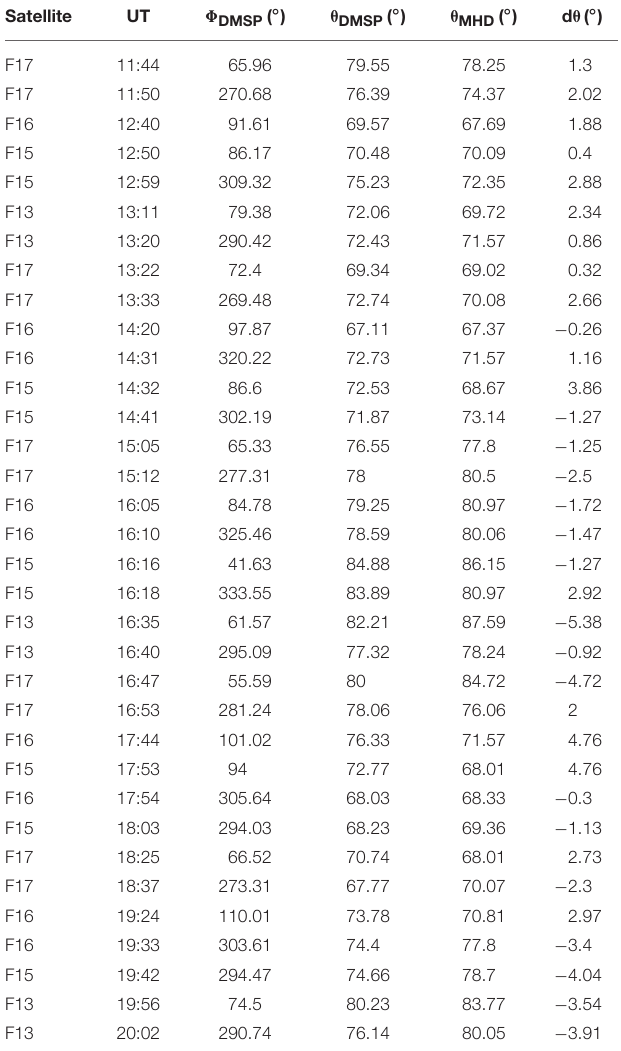
TABLE 1 | A list of DMSP PCB crossings at the northern hemisphere during the 8 March 2008 event.